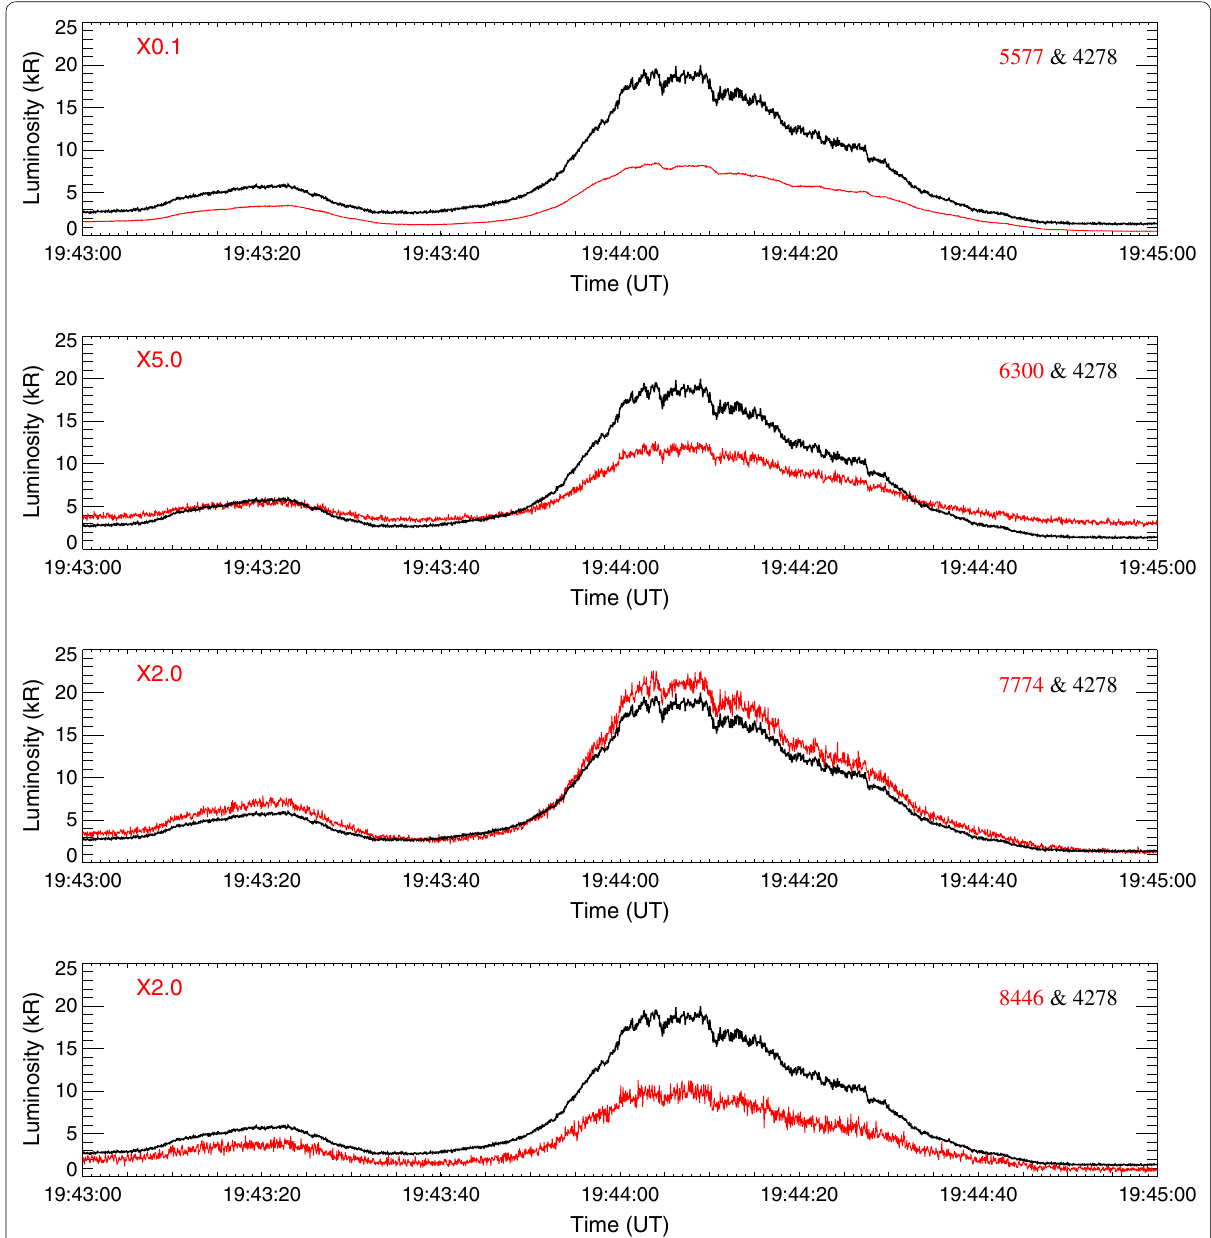
Fig. 14 Comparisons of temporal variations of auroral emissions (20 Hz data used) between 427.8 nm (black) and 557.7 nm, 630 nm, 777.4 nm, and 844.6 nm from top to bottom are presented between 19:43:00 UT and 19:45:00 UT on January 22, 2018. The emission intensities of 557. 7 nm, 630 nm, 777.4 nm, and 844.6 nm are multiplied by 0.1, 5, 2, and 2, respectively, and denoted in red solid